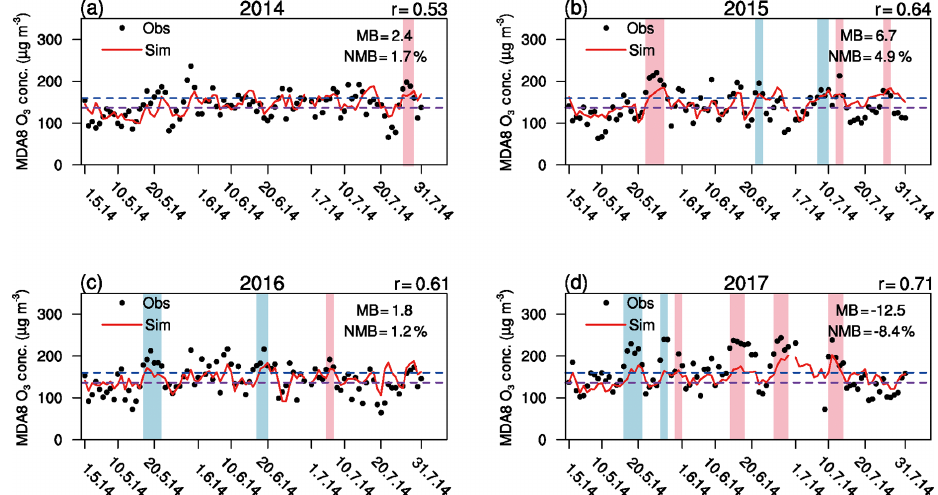
Figure 7. Daily variations in observed (black dots) and simulated (solid red lines) regional mean MDA8 O 3 (µgm − 3 ) in North China during the months of May to July of 2014–2017. The dashed blue and dashed purple lines indicate the thresholds of 160 and 136.6µgm − 3 for observation and simulation, respectively. OPEs captured by the GEOS-Chem model with I_OPE > 0 are highlighted by pink rectangles (OPEs with simulated MDA8 O 3 concentrations larger than 160µgm − 3 ) and by blue rectangles (OPEs with simulated MDA8 O 3 concentrations larger than 136.6µgm − 3 but including days with simulated MDA8 O 3 smaller or equal to 160µgm − 3 ). Correlation coefficient between observed and simulated MDA8 O 3 concentrations for each year is shown above the top right corner of each plot. The mean bias (MB) and normalized mean bias (NMB) are calculated by MB = 1 observed and simulated MDA8 O 3 concentrations on the i day, respectively, and n indicates the number of days.